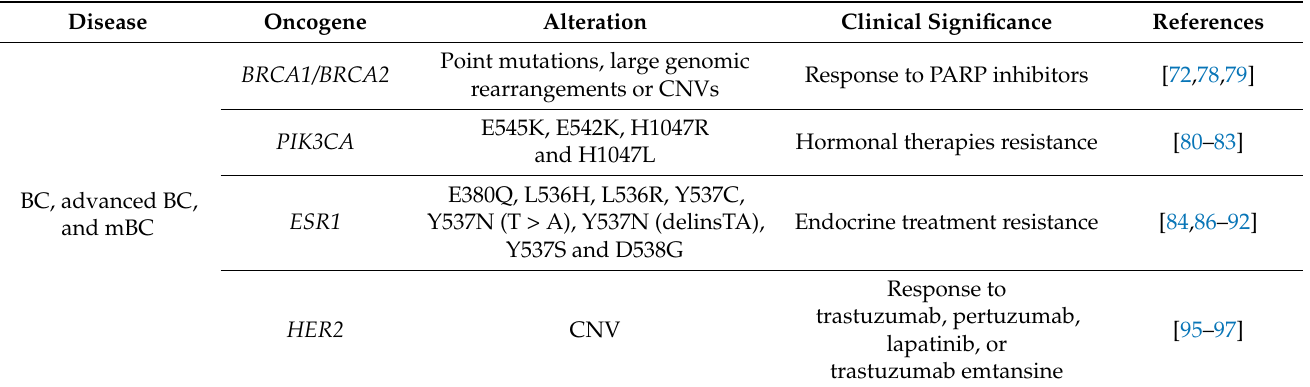
Table 3. Most relevant molecular alterations detected via ctDNA ddPCR assays and their clinical significance in BC. Disease Oncogene Alteration Clinical